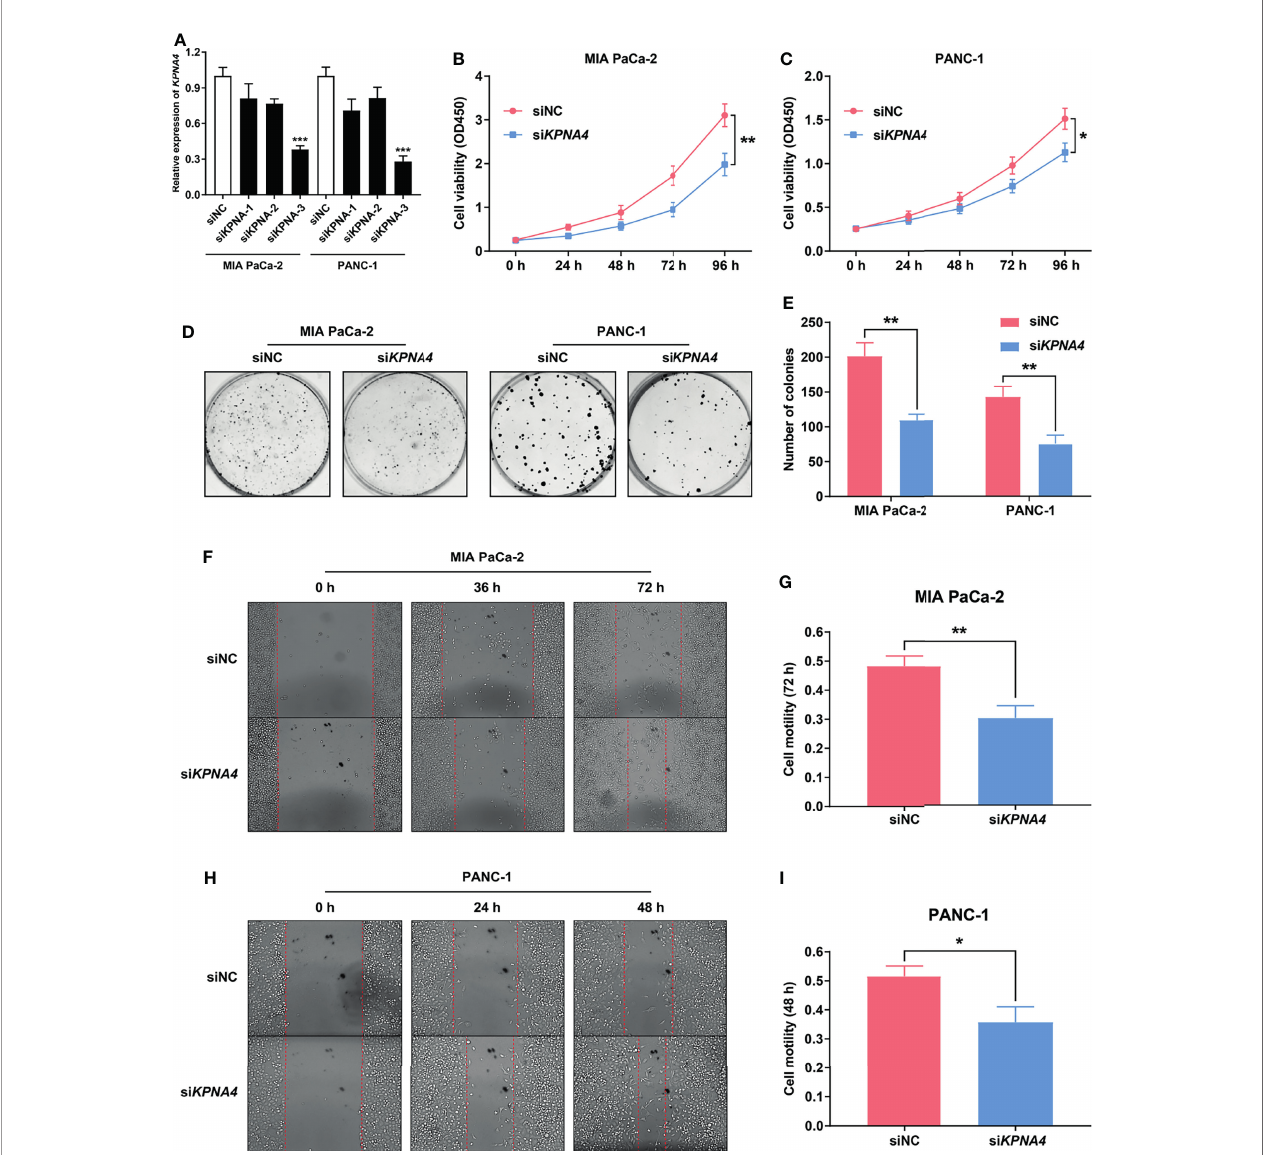
FIGURE 4 | KPNA4 knockdown inhibits proliferation and migration of PDAC cells. Knockdown ef fi ciency of three siRNA on KPNA4 was detected by qRT-PCR (A) . KPNA4 knockdown suppressed cell proliferation of MIA PaCa-2 (B) and PANC-1 cells (C) . KPNA4 knockdown inhibited the colony formation of MIA PaCa-2 and PANC-1 cells (D, E) . The inhibitory effect of KPNA4 knockdown on MIA PaCa-2 (F) and PANC-1 (H) cell migration was evaluated by wound healing assay at different time points, and the migration index was shown in (G, I) . * p < 0.05, ** p < 0.01, *** p <